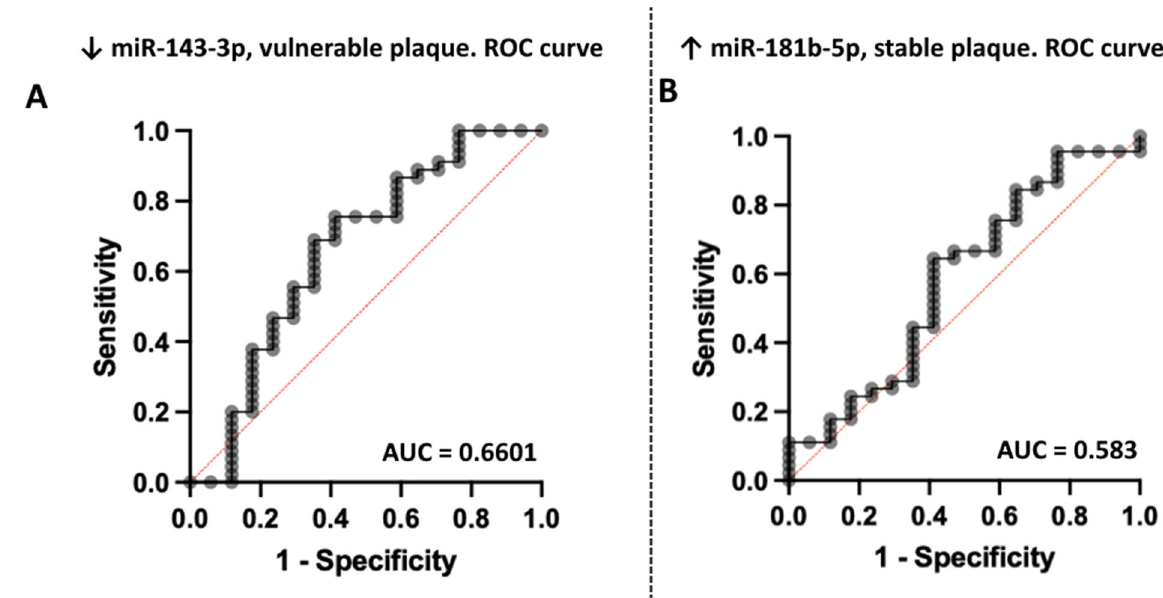
Figure 3. Results of sensitivity and specificity analysis of ( A ) miR ‐ 143 ‐ 3p relative plasma levels decrease as a marker of plaque vulnerability and ( B ) increase in miR ‐ 181b ‐ 5p levels as a marker of plaque stability. ROC curves.